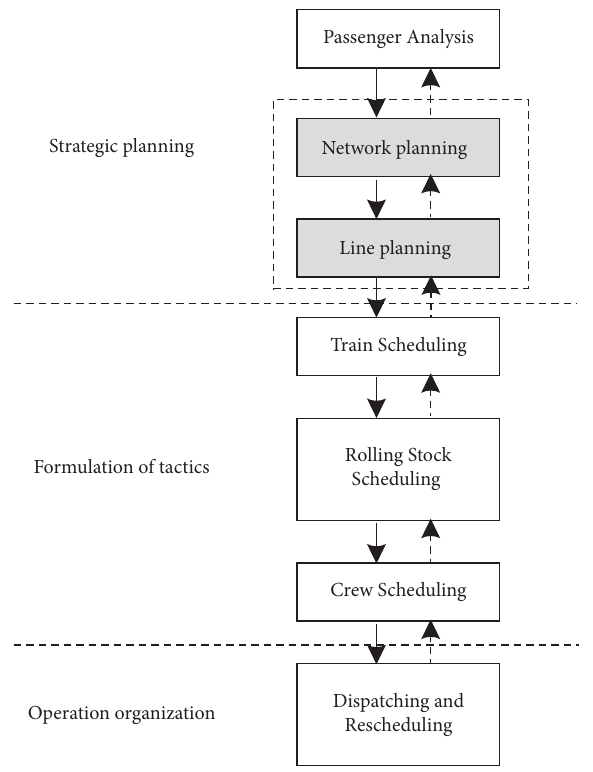
Figure 1: URT planning